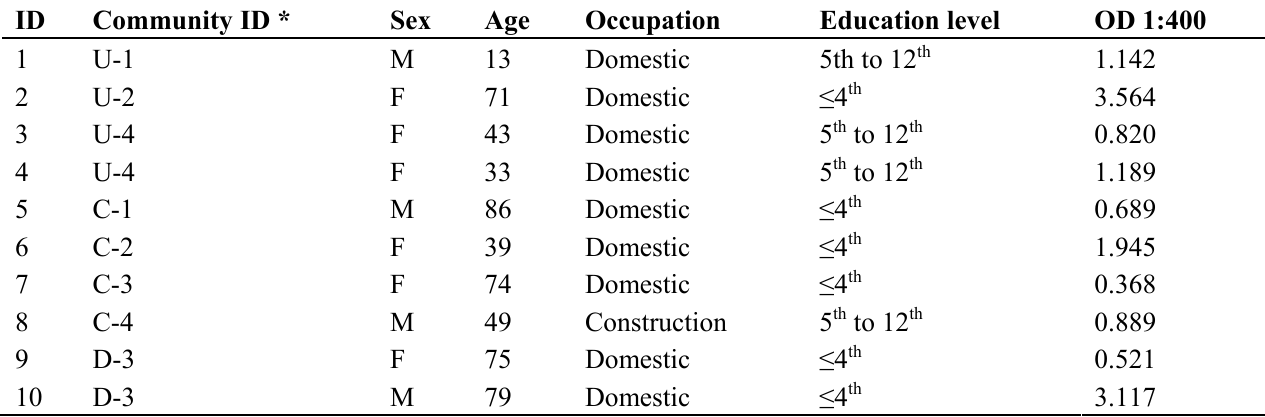
Table 2. ELISA Optical Density (OD) results of a total of 934 participants from 12 communities who tested positive for ANDV IgG antibodies. Samples with OD ≥ 0.3 are considered